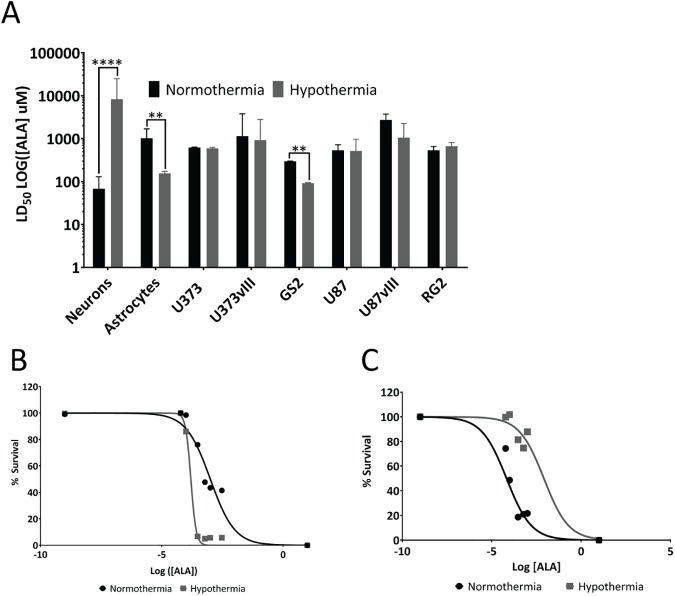
Mild hypothermia modulates PDT responsivity of cell lines and primary neuronal cells in vitro.A) LD50 values of 5 glioma cell lines, one purported glioma cancer stem cell line (GS2), as well as primary murine neurons (DIV 13) and astrocytes of PDT with and without hypothermia, note LD50 of ALA, was chosen as a surrogate for PDT dose in these studies. Hypothermia altered LD50 significantly from primary neurons and astrocytes, as well as GS2 cells (p<0.05, n = 3). B) Normalized dose-response curve of primary astrocytes and C) of primary neurons.